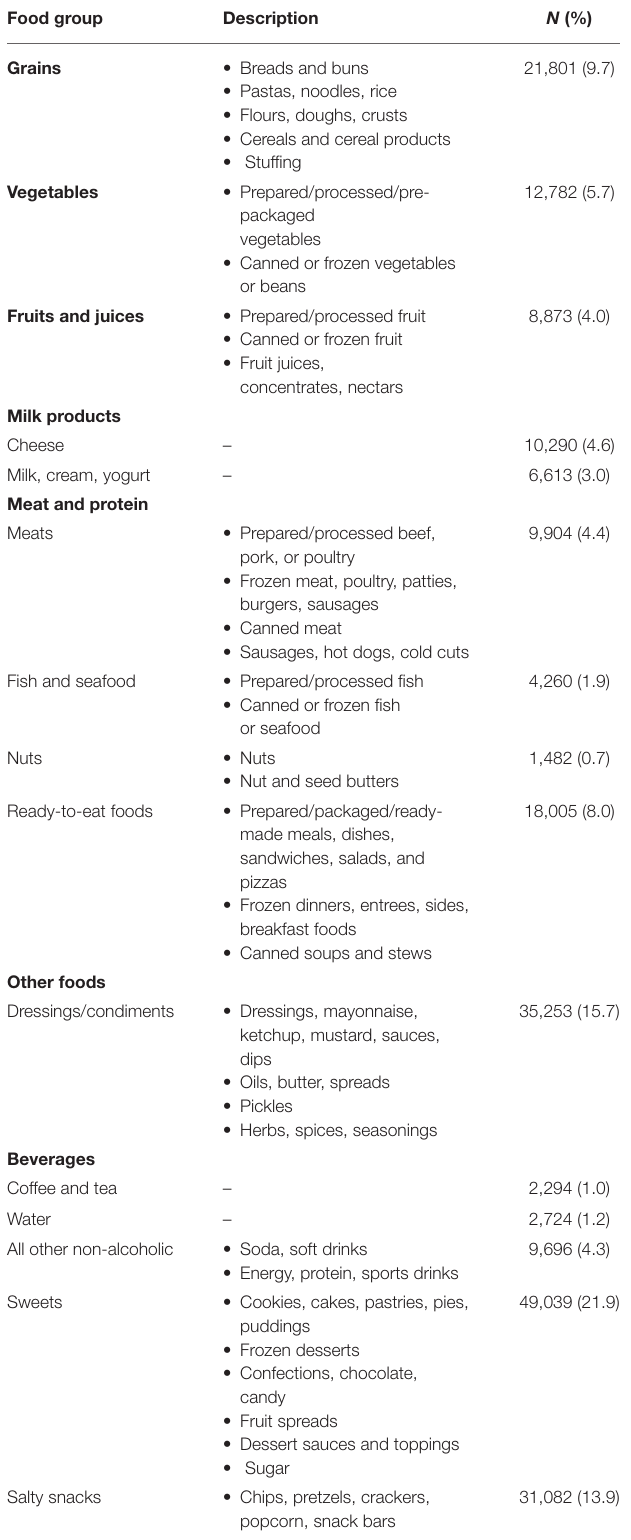
TABLE 2 | Description and distribution of 15 food groups (representing seven food categories) used in analysis of Branded Food Products Database food items ( N =